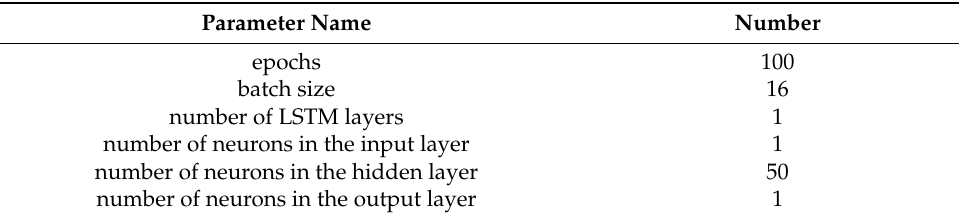
Table 3. The optimal parameters and structure of